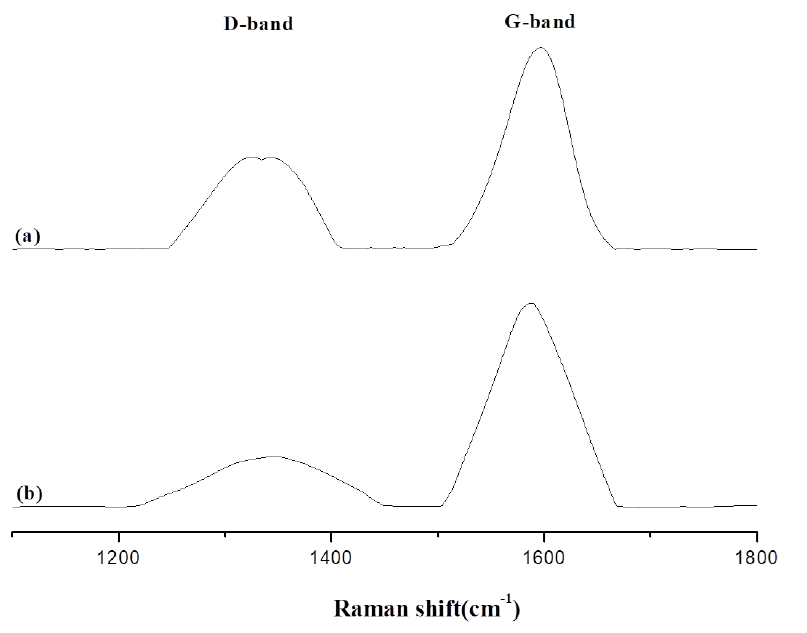
Figure 7. Raman spectra of biochar products from Epoxy/Bagasse@TGIC@DOPO IPN 30% at 800 °C ( a ) 1 min, ( b ) 5 min. Table 2. D/G for the Raman shift from Epoxy/Bagasse@TGIC@DOPO IPN composites biochar. D-Band G-Band Sample No. D/G 1350 cm − 1 1580 cm − 1